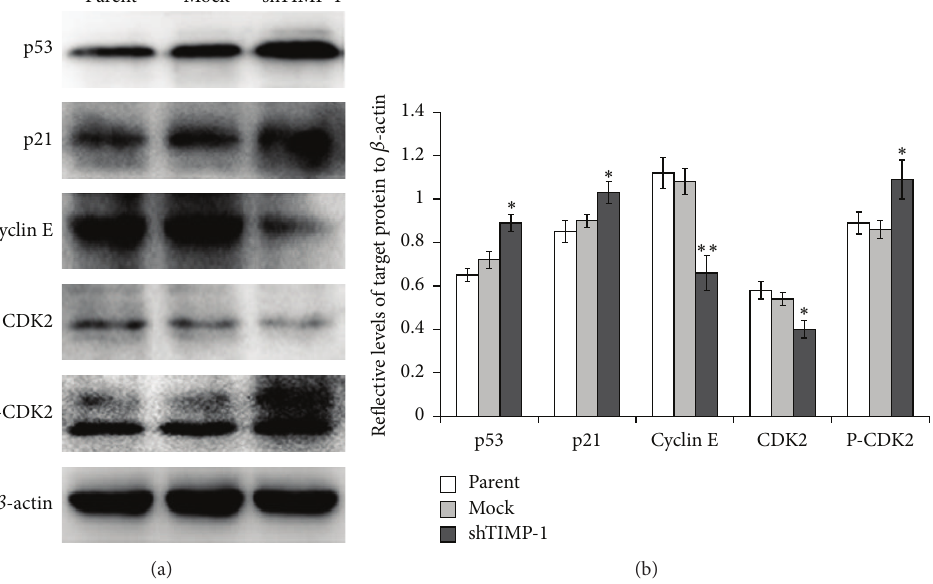
Figure 6: Effects of TIMP-1 knockdown on p53 protein and cell cycle biomarkers. The levels of p53, p21, cyclin E, CDK2, and P-CDK2 proteins were analyzed by western blotting after TIMP-1 knockdown. (a) The representative western blot images. (b) The expression levels of p53, p21, cyclin E, CDK2, and P-CDK2 were quantified by the densitometry of each band and were normalized by internal loading control, 𝛽 -actin. The data represent the mean ± SD ( 𝑛 = 3 ). ∗ 𝑃 < 0.05 and ∗∗ 𝑃 < 0.01 versus the mock-shRNA groups. Parent: uninfected ADSCs; mock: control lentivirus infected ADSCs; shTIMP-1: shRNA-TIMP-1 lentivirus infected